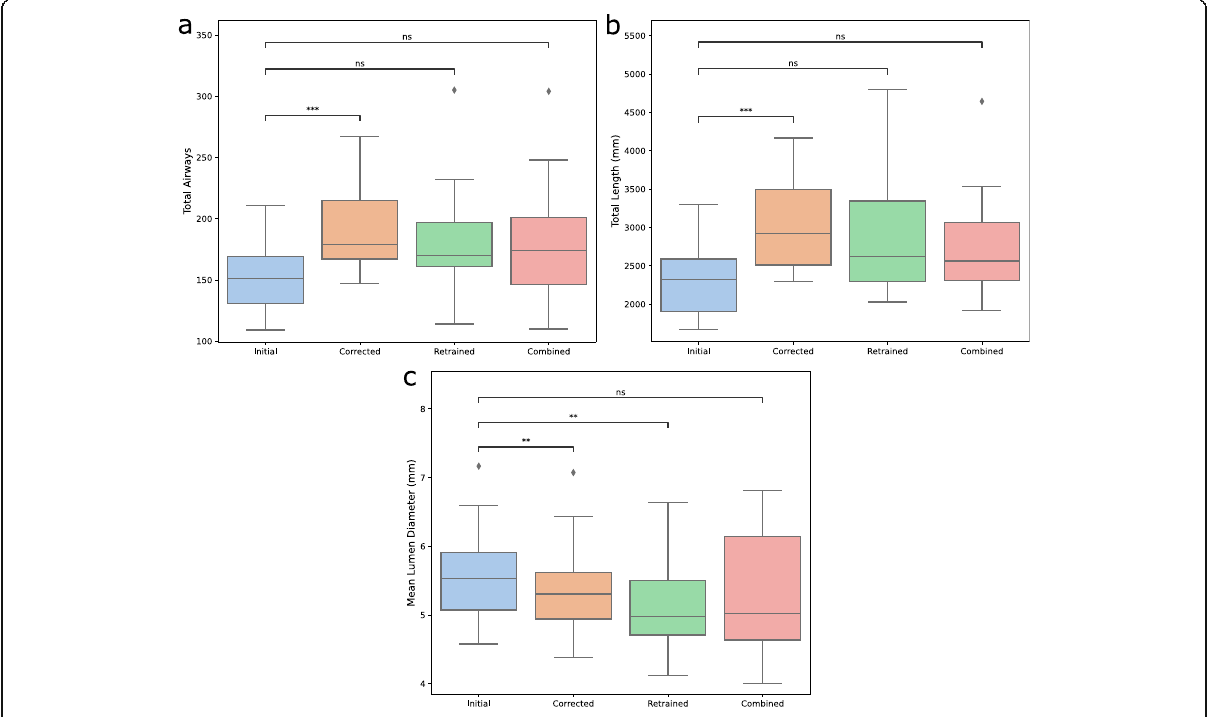
Fig. 4 Boxplots for retrained and for combined retrained 3D-Unets. a Total airway count per segmentation. b Total airway length per segmentation. c Median luminal diameter per segmentation. ns not significant, * p < 0.05, ** p < 0.01, *** p <